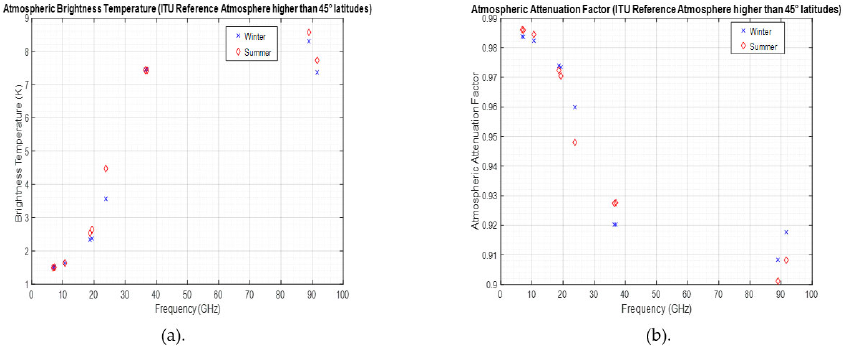
Figure 6. ( a ) Atmospheric brightness temperature and ( b ) atmospheric attenuation factor versus frequency based on the high latitude reference atmosphere defined in Rec ITU ‐ R P.835 ‐ 6.